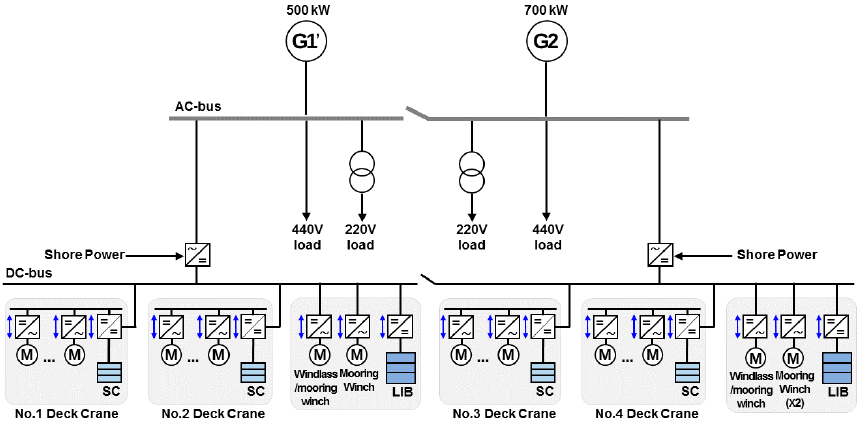
Figure 4. Layout of the proposed power system.